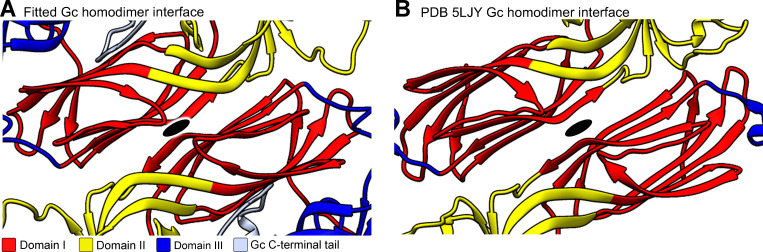
Domain I mediates dimer contacts at the Gc–Gc interface.(A) Gc homodimer interface generated by fitting Puumala virus (PUUV) GcGc-P-4G2 into a cryo-ET reconstruction of PUUV virus-like particle (VLP) surface at 13.9 Å resolution (see also Figure 6C). Within the constraints of low-resolution fitting, the interface matches with the homodimerization interface from the (B) crystallographically observed HTNV Gc dimer (Guardado-Calvo et al., 2016). The twofold symmetry axis is indicated by an oval.